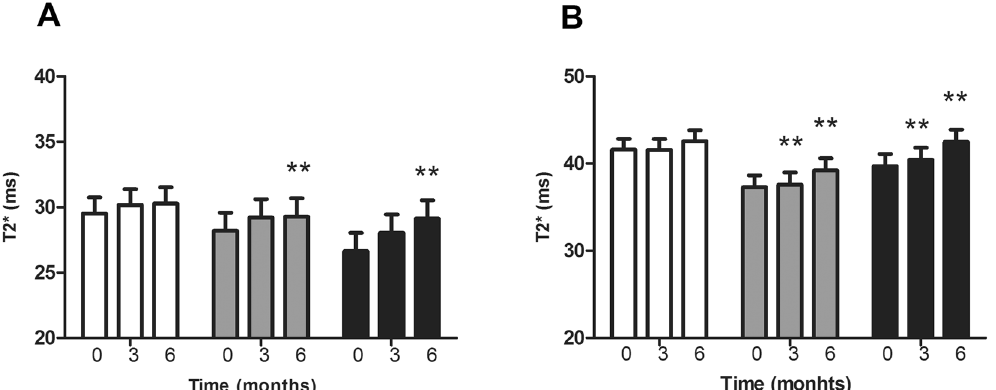
Figure 3. Mean T2 * MRI values in the dentate nucleus ( A ) and caudate nucleus ( B ) of Parkinson’s disease subjects receiving 20 mg/kg/day, (grey bars, n = 6) or 30 mg/kg/day (black bars n = 5) mg/kg/day deferiprone or placebo (open bars, n = 8) at 3 months and 6 months. Values are represented as mean ± SEM. T2 * value is prior to the commencement of treatment, and then after 3 and 6 months of drug treatment. ** p < 0.01 as assessed by Pairwise comparison.